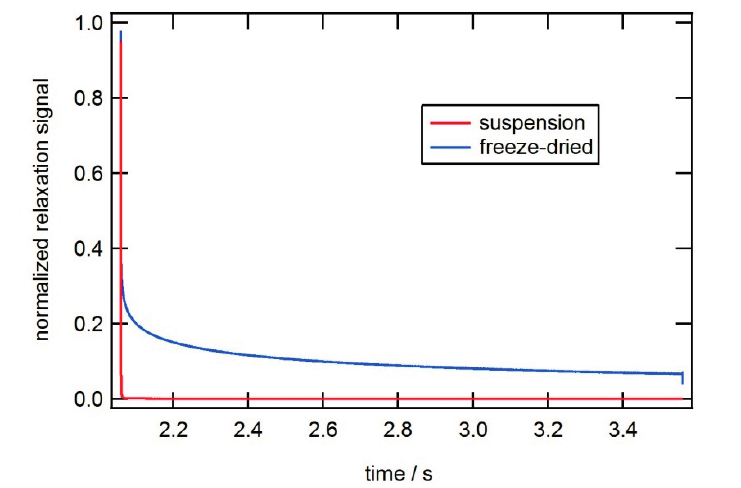
Figure 7. MRX (magnetorelaxometry) data at room temperature of a magnetic single-core particle system ( CSIC04 ) that shows Brownian relaxation when particles are suspended in liquid (in red), and long Néel relaxation when the particles are immobilized (in